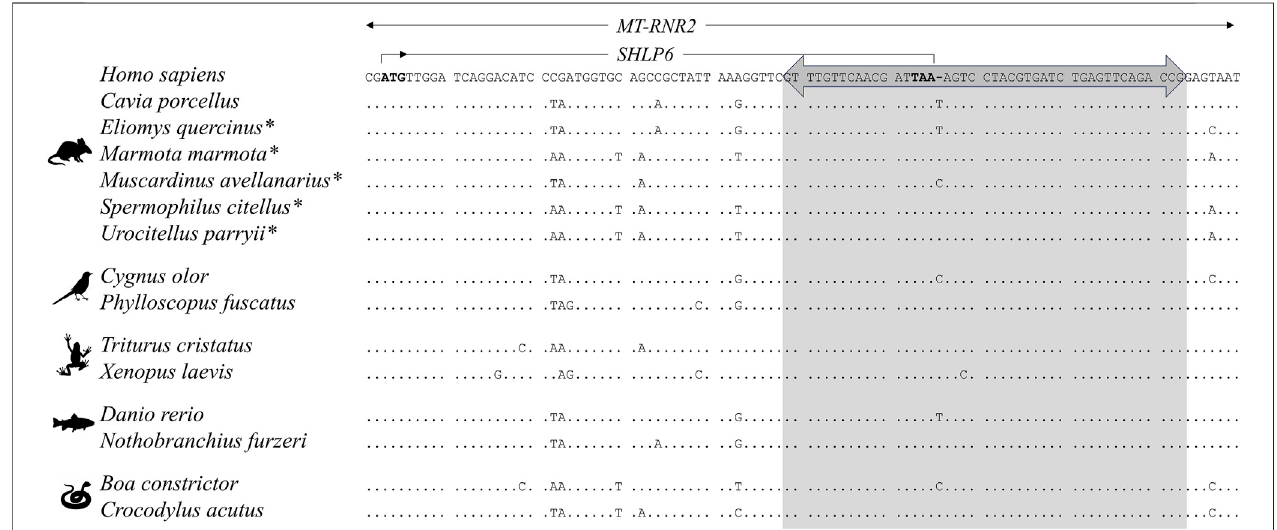
FIGURE2| Targetsitesoftheuniversalback-to-backprimersarelocatedintheconservedregionof MT-RNR2 (greybox)andincludepartofthe SHLP6 -encoding sORFs. Representatively, two species were selected for different classes of the subphylum Vertebrata. Asterisk: target species of this study; dot: identity with human sequence; hyphen: nucleotide gap; speci fi c base: single-nucleotide polymorphism (SNP). Note that the back-to-back primers are completely homologous to the main mtDNA haplotypes of Homo sapiens (data not shown).